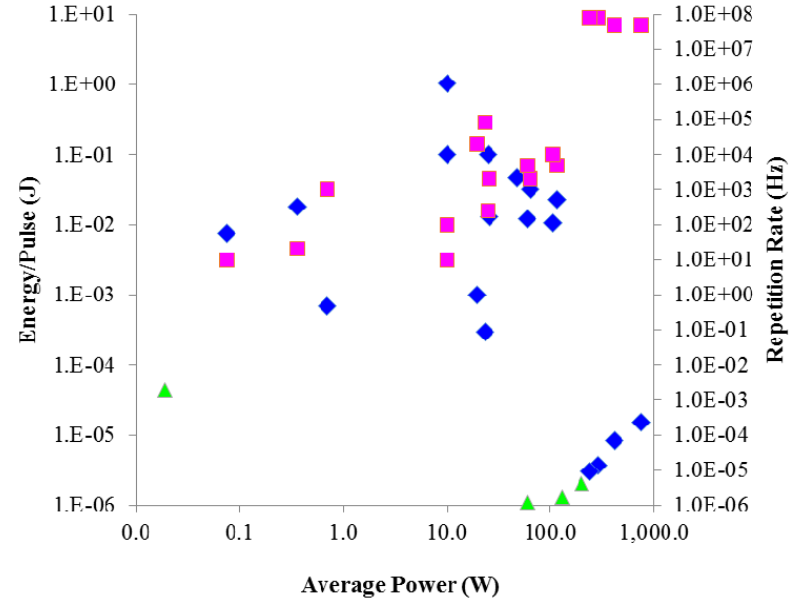
Figure 47. Yb:YAG, Yb:YLF, Yb:Y 2 O 3 , and Yb:YAG + Yb:GSAG compressed or direct energy/pulse at fundamental (blue) and second-harmonic (green) wavelengths, and repetition rate (pink), as a function of average power. Numerical values and references are taken from Table 10.